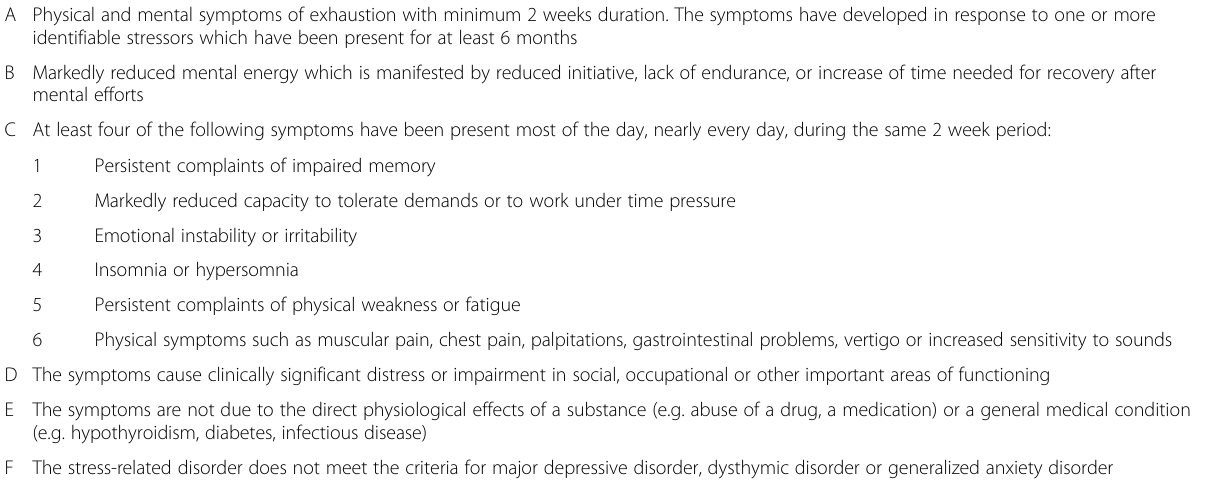
Table 1 Diagnostic criteria for Exhaustion syndrome, ICD-10 code